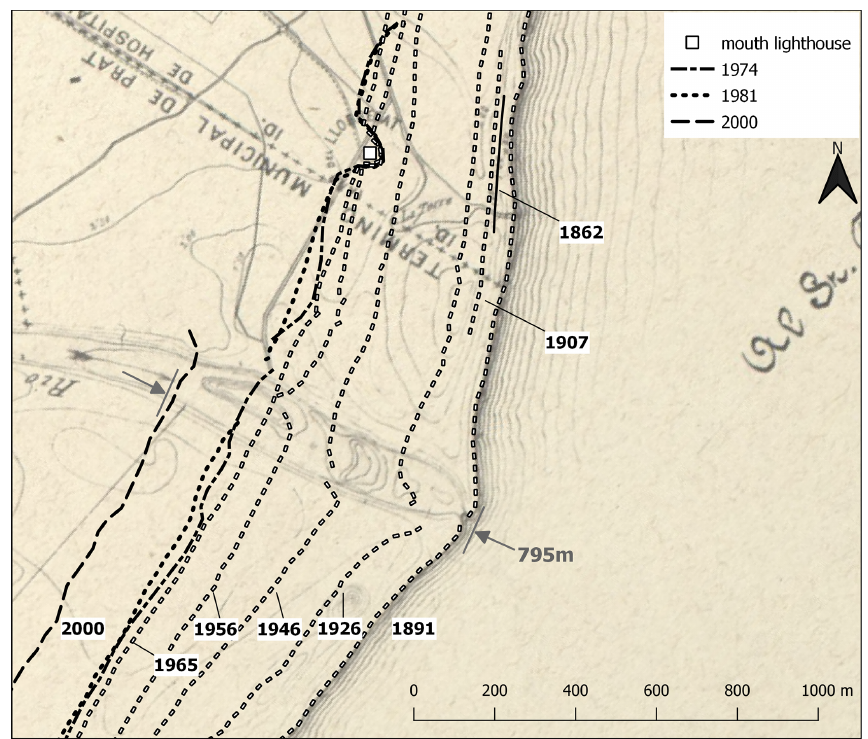
Figure 2. Coastline retreat in the Llobregat delta since 1891 (date of the map in the background, as well). Figure produced by authors using our own and freely available data from Institut Cartogràfic i Geològic de Catalunya (ICGC). The 1862 line comes from Marcos (1995). The lighthouse was built as a watchtower in 1567. Drawings show its location well inland in the 17th century. It was turned into a lighthouse in 1852 to prevent ships from getting stuck in the sandbanks of the river